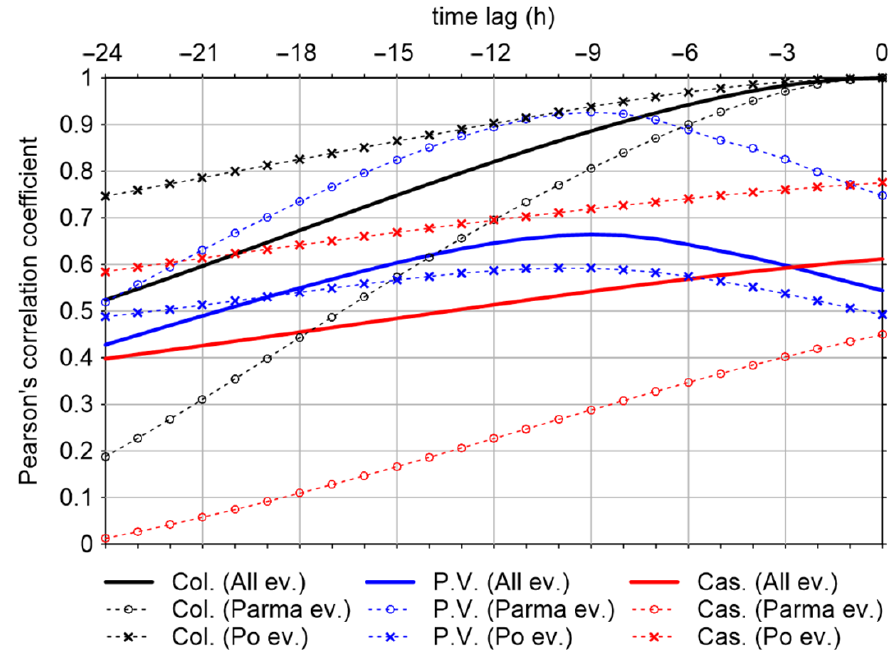
Figure 5. Correlation coefficients between the current water stage at Colorno and the preceding water stage at Ponte Verdi, Casalmaggiore, and Colorno stations.